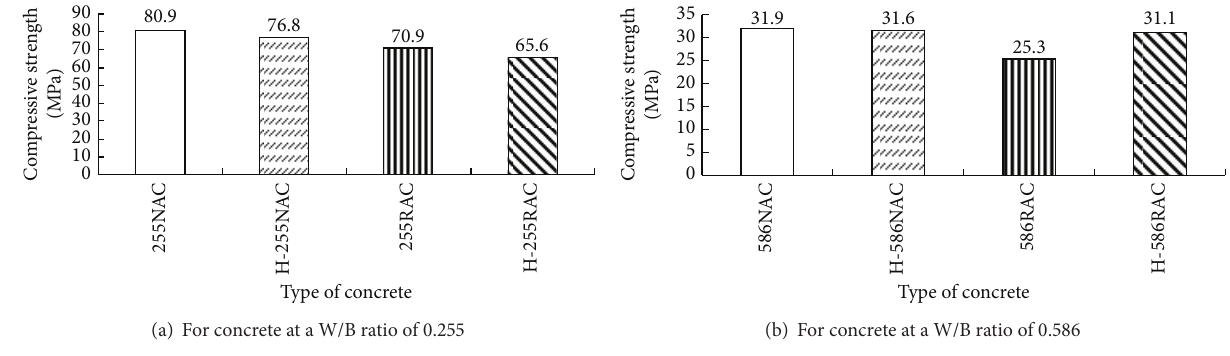
Figure 4: Compressive strength of concrete at W/B ratios of 0.255 and 0.586.